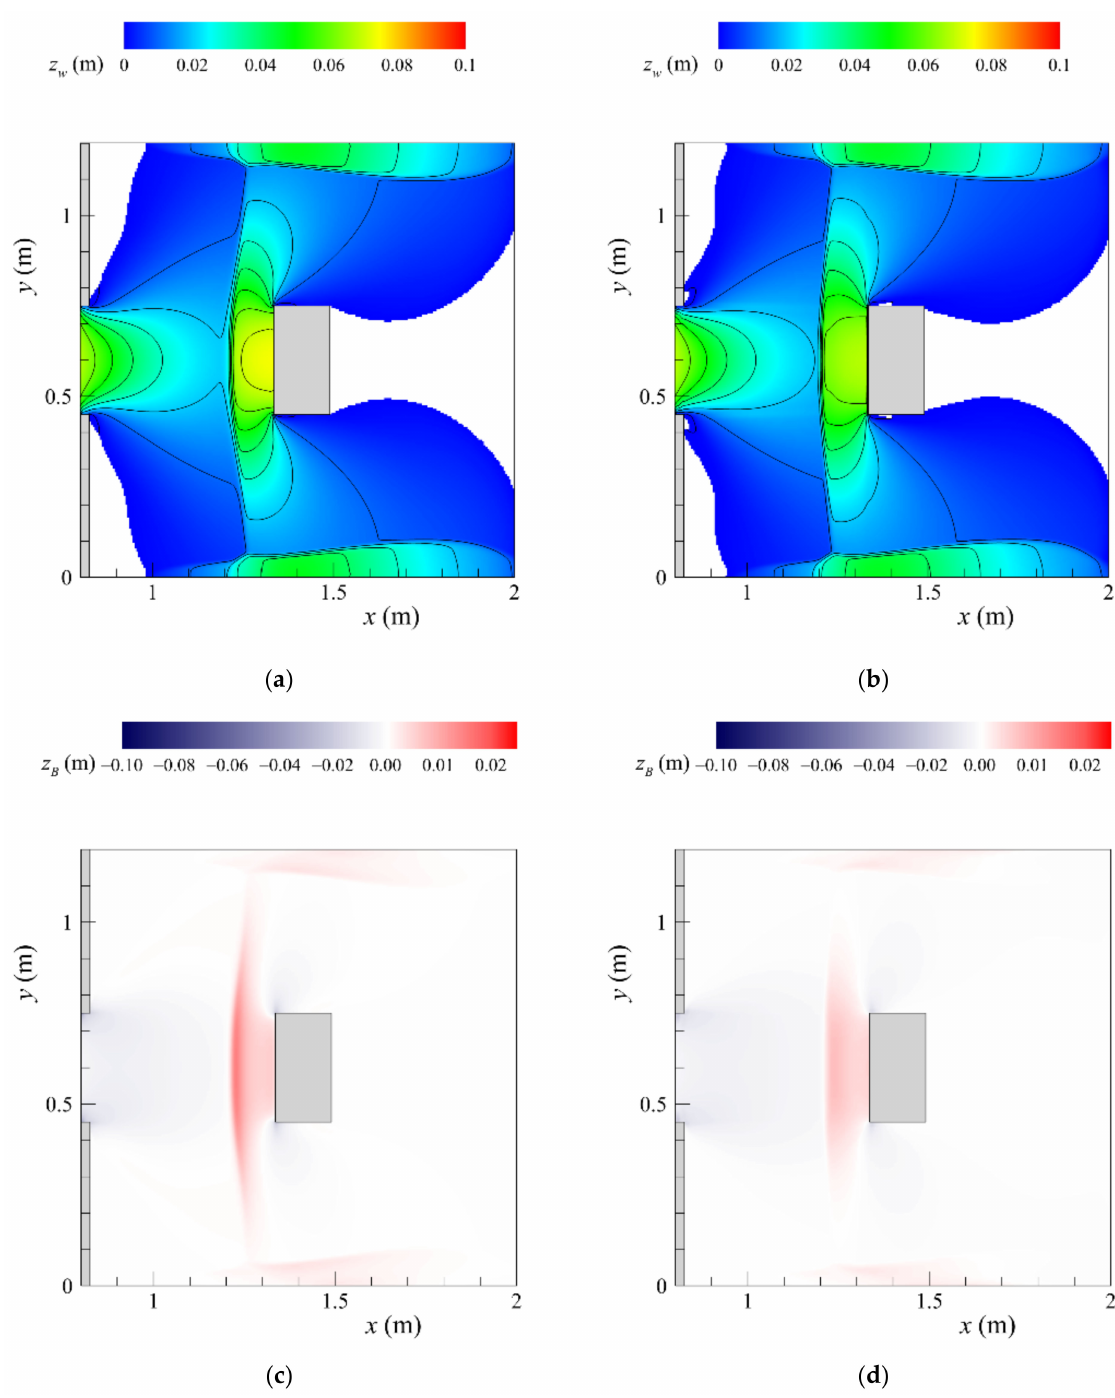
Figure 4. Results for sand particle d = 5 × 10 − 4 m at t = 1.5 s: ( a ) free-surface elevation predicted by the SVEM; ( b ) free-surface elevation predicted by the TPM; ( c ) bottom elevation predicted by the SVEM; ( d ) bottom elevation predicted by the